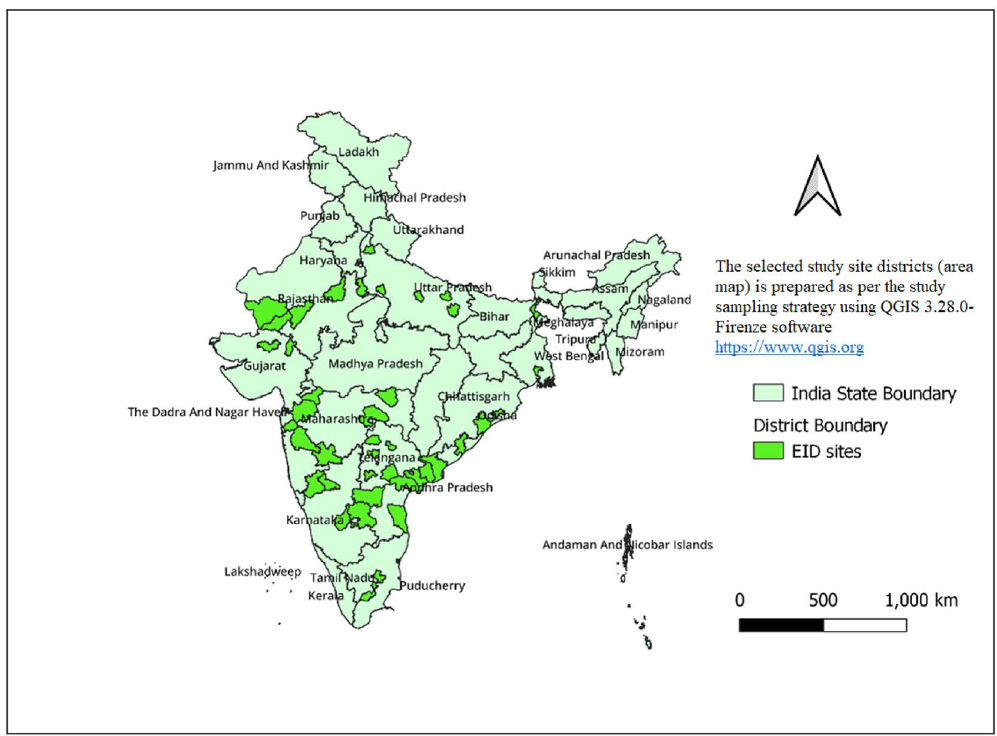
Figure 1. Geographic distribution of the selected ICTCs (districts shown in map) for assessment of EID program, India. ( Note : The Fig. 1 to illustrate the selected study site districts (area map) is prepared as per the study sampling strategy using QGIS 3.28.0-Firenze software, QGIS Geographic Information System, QGIS Development Team (2021), Open Source Geospatial Foundation Project, https:// www. qgis. org by the study team. Any use or reproduction of this figure requires approval from corresponding